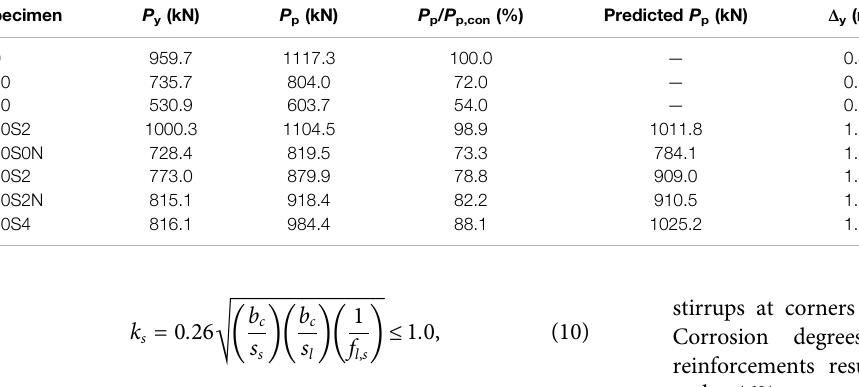
TABLE 3 | Loading capacity, deformation, and ductility.